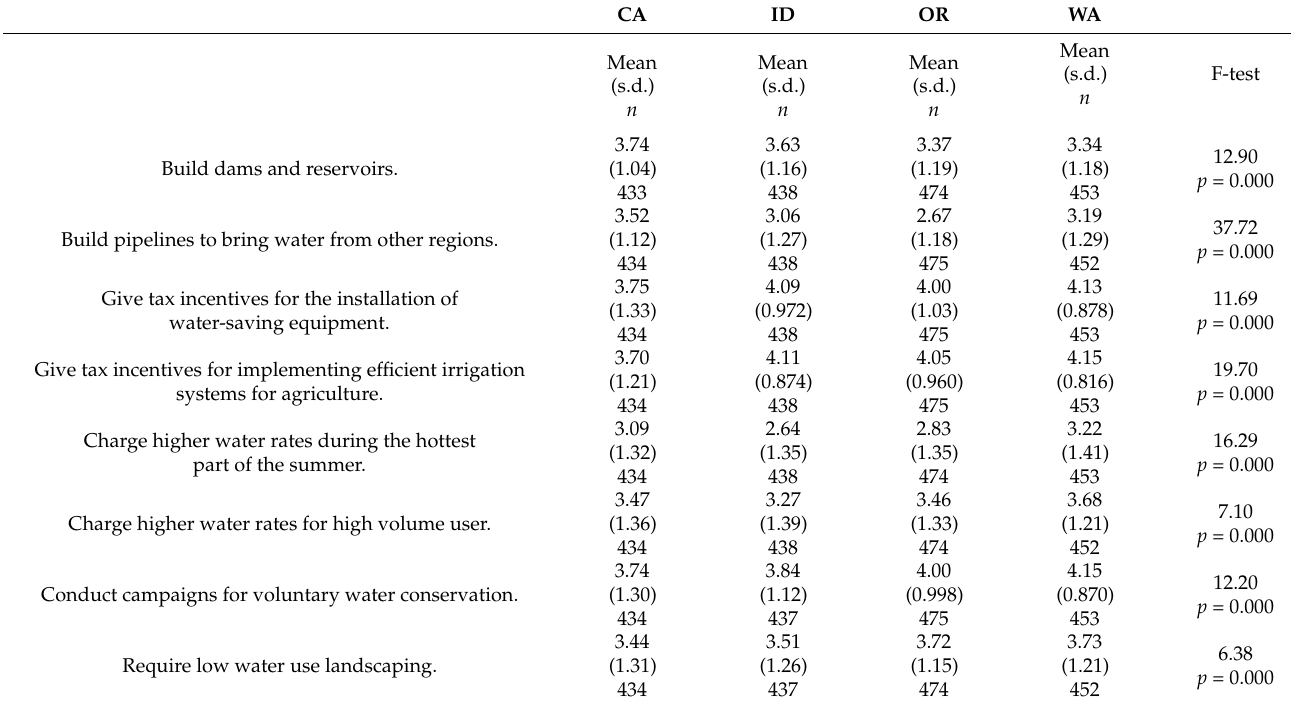
Table 3. Water Policy Preferences by